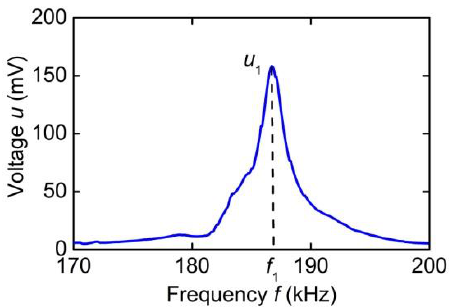
Figure 23. Dependence of ME voltage u on the current frequency f for a monolithic Cu/NZFO/Cu-PZT heterostructure with an integrated excitation system at I = 0.1 A and H = 95 Oe.